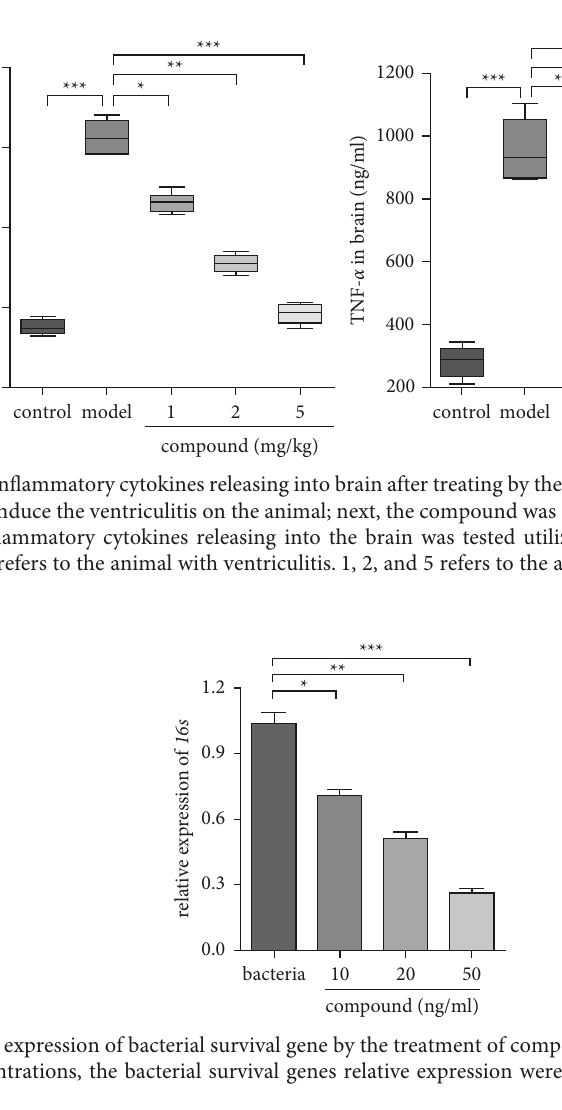
Table S1: selected bond lengths (˚A) and angles ( ° ) for 1. Table S2: the related hydrogen bond parameters for compound 1.